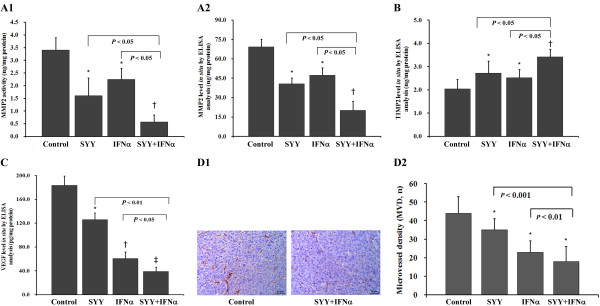
Detection of VEGF, MMP2, TIMP2, and MVD. (A1) Tumor MMP2 activities. *P < 0.05, †P < 0.01 compared with control. (A2) Tumor MMP2 levels. *P < 0.05, †P < 0.01 compared with control. (B) Tumor TIMP2 levels. *P < 0.01, †P < 0.001 compared with control. (C) Tumor VEGF levels. *P < 0.05, †P < 0.01, ‡P < 0.001 compared with control. (D1) Representative CD34 immunostained intratumoral microvessels (original magnification, ×200) in control group (left) and in the SYY + IFN-α group (right), bar, 50 μm. (D2) Tumor microvessel density (MVD). *P < 0.001 compared with control. The bars indicate the means ± SD.